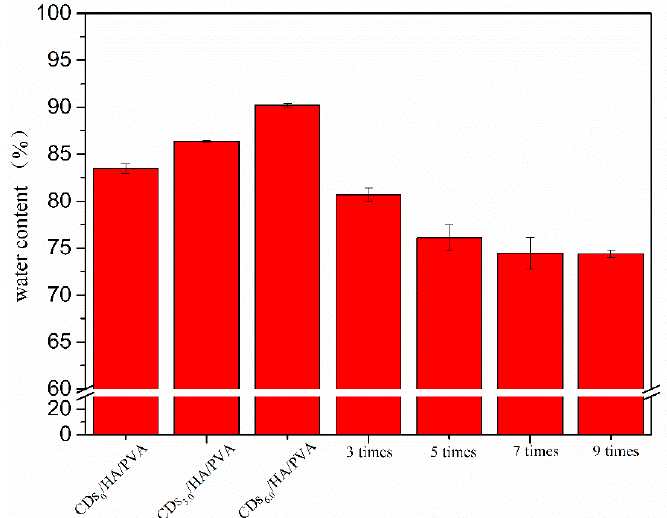
Figure 8. The water contents of the CDs/HA 0.6 /PVA SN hydrogels with different mass ratios of CDs to PVA at 0%, 3.0%, and 6.0% and CDs 3.0 /HA 0.6 /PVA DN hydrogels with 3, 5, 7, and 9 freezing/thawing cycles, respectively.